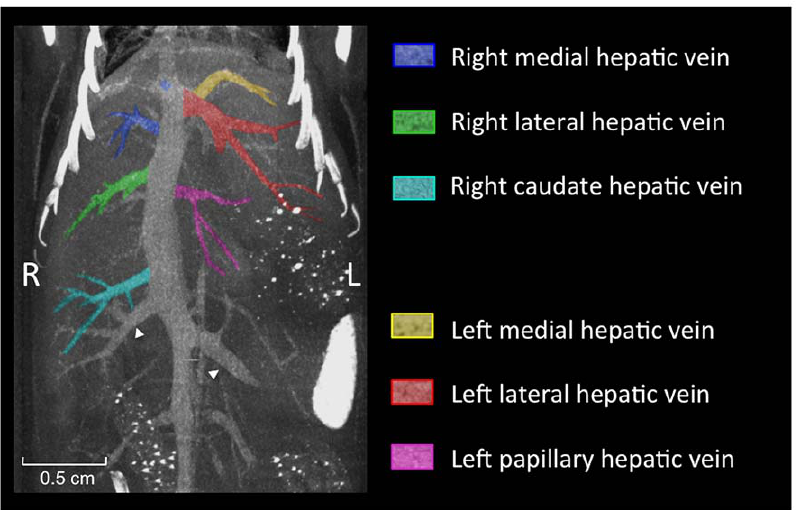
Figure 7. Hepatic veins. Maximum intensity projection (MIP) of micro-CT images of the murine hepatic veins 20 minutes after injection of 400 m l Fenestra VC. The color coding of the draining veins corresponds to the color coding used for the liver lobes before. The renal veins are indicated by arrowheads.